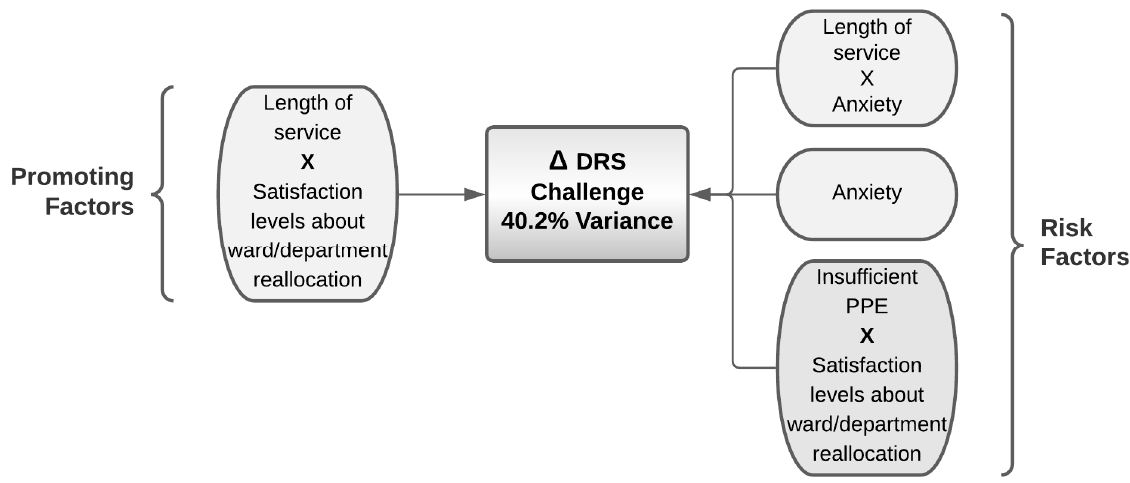
Figure 7. Promoting and risk factors for the variance in the hardiness assessed by DRS challenge resulting from the logistic regression.